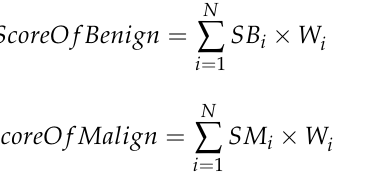
Figure 3. Original MRI and three kinds of ROI. ( a , e ) belong to the original. MRI images. ( b , f ) were SBBL-ROI. ( c , g ) were SBBS-ROI. ( d , h ) were SL-ROI. ( a – d ) belonged to a malignant lesion and ( e – h ) belonged to a benign lesion.